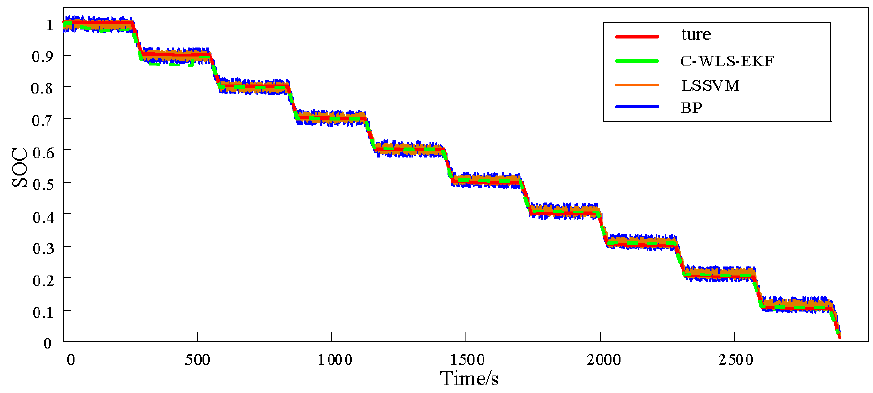
Figure 12. Comparison of C-WLS-EKF and intelligent algorithm estimation results.